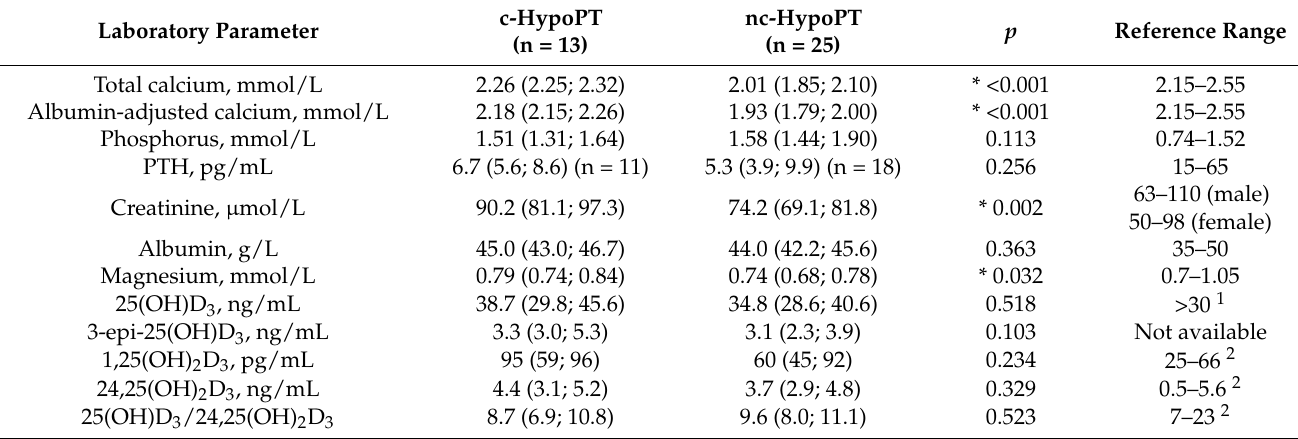
Table 4. Results of the laboratory evaluation in compensated and non-compensated